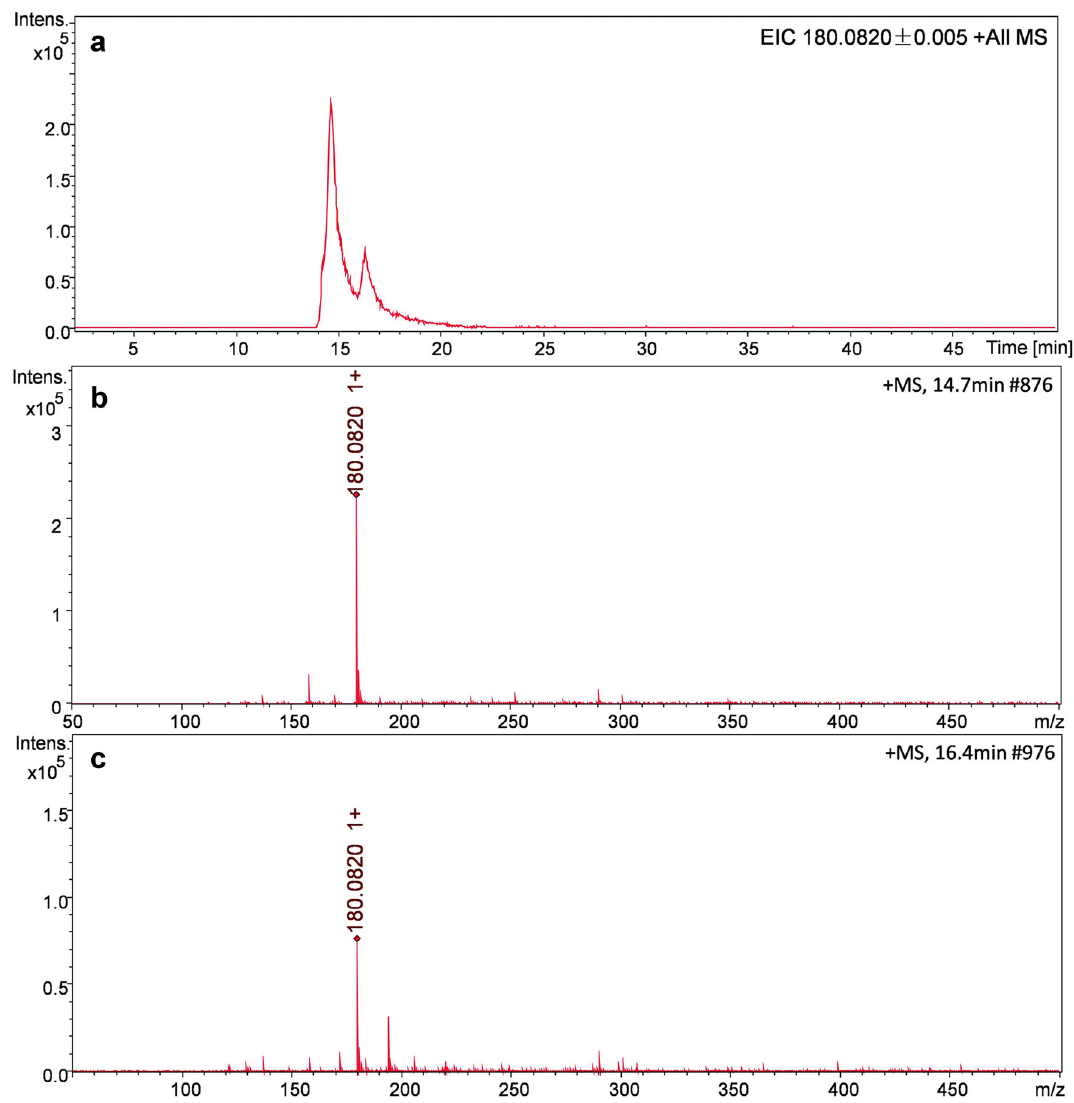
Fig. 8 EIC ( a ) and mass spectra ( b and c ) of isomers of [C 13 H 10 N] ? ( m / z = 180.0820) detected by